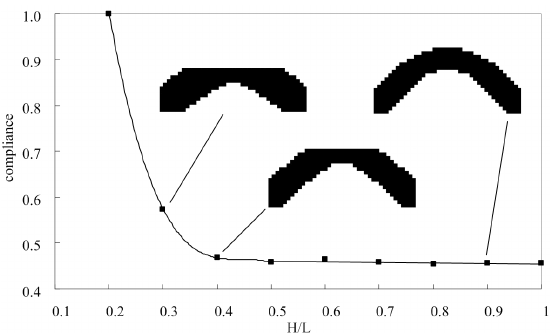
Fig. 16 3D optimal configurations under pressure load